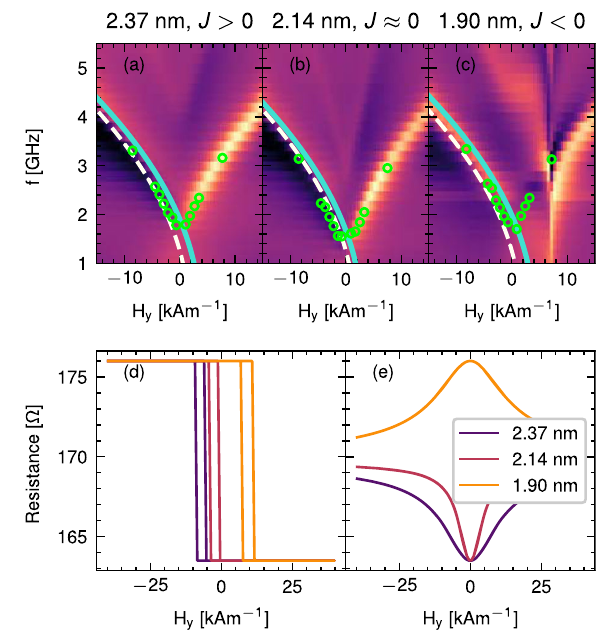
Fig. 4 Spin valve simulations of CoFe(2.1 nm)/Cu(1.9 – 2.37 nm)/ CoFe(1 nm)/NiFe(5 nm) sample for three different values of Cu thickness which result in different IEC magnitudes. a – c Kittel dispersion relations, with the blue dots marking the experimental data. Resistance loops at ϕ H = 90° ( d ) and at ϕ H = 0° ( e ) applied external magnetic fi eld with ϕ denoting the polar angle. Solid turquoise lines mark the fi t to Kittel ’ s formula, Eq. (4) and ivory dashed line represents simulated data from the free-energy Smit – Beljers model. Discrepancies between Kittel and Smit – Beljers model may come from the fact that the latter is better suited to multilayer systems. Parameters of the system may be found in Supplementary Table